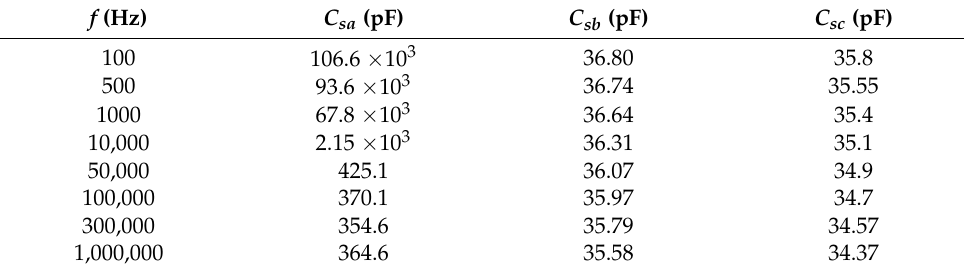
Table 5. Series capacitance test results for LPVT A at 10 V.